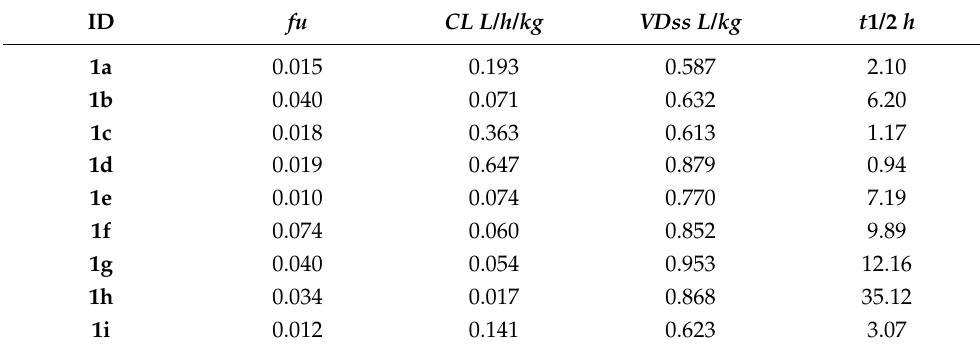
Table 5. PK parameters of the designed arylsulfonyl hydrazones: fu — fraction of the compound unbound to plasma proteins; CL — total clearance in L/h/kg; VDss — steady-state volume of distribution in L/kg; t 1/2 — half-life in h.